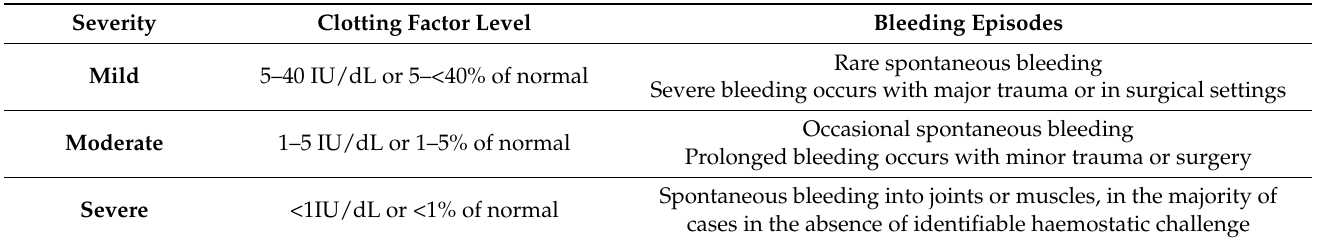
Table 1. Severity of bleeding in relationship to clotting factor levels